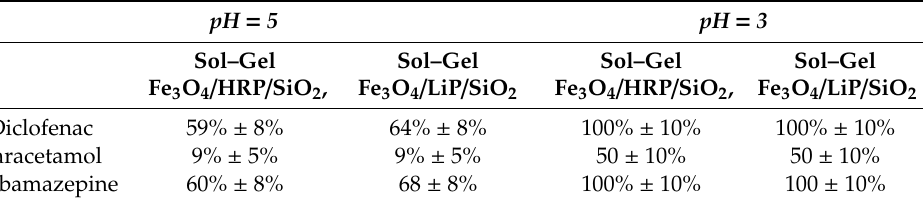
Table 1. Activity of LiP and HRP composites in drug decomposition processes over 3 days, 55 °C at